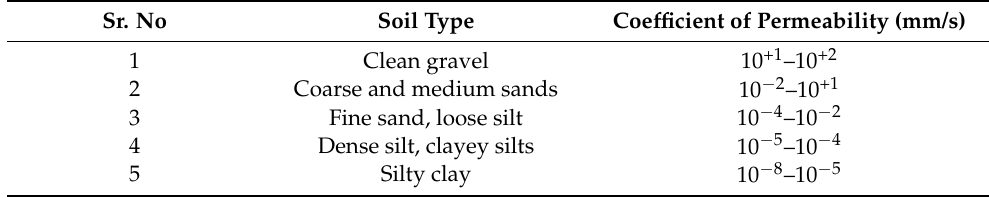
Figure 5. ( a ) Groundwater level rises by recharge well, and ( b ) Schematic diagram of filter. Table 1. Typical ranges of permeability coefficients for different soil types [45]. Coefficient of Permeability Sr. No Soil Type